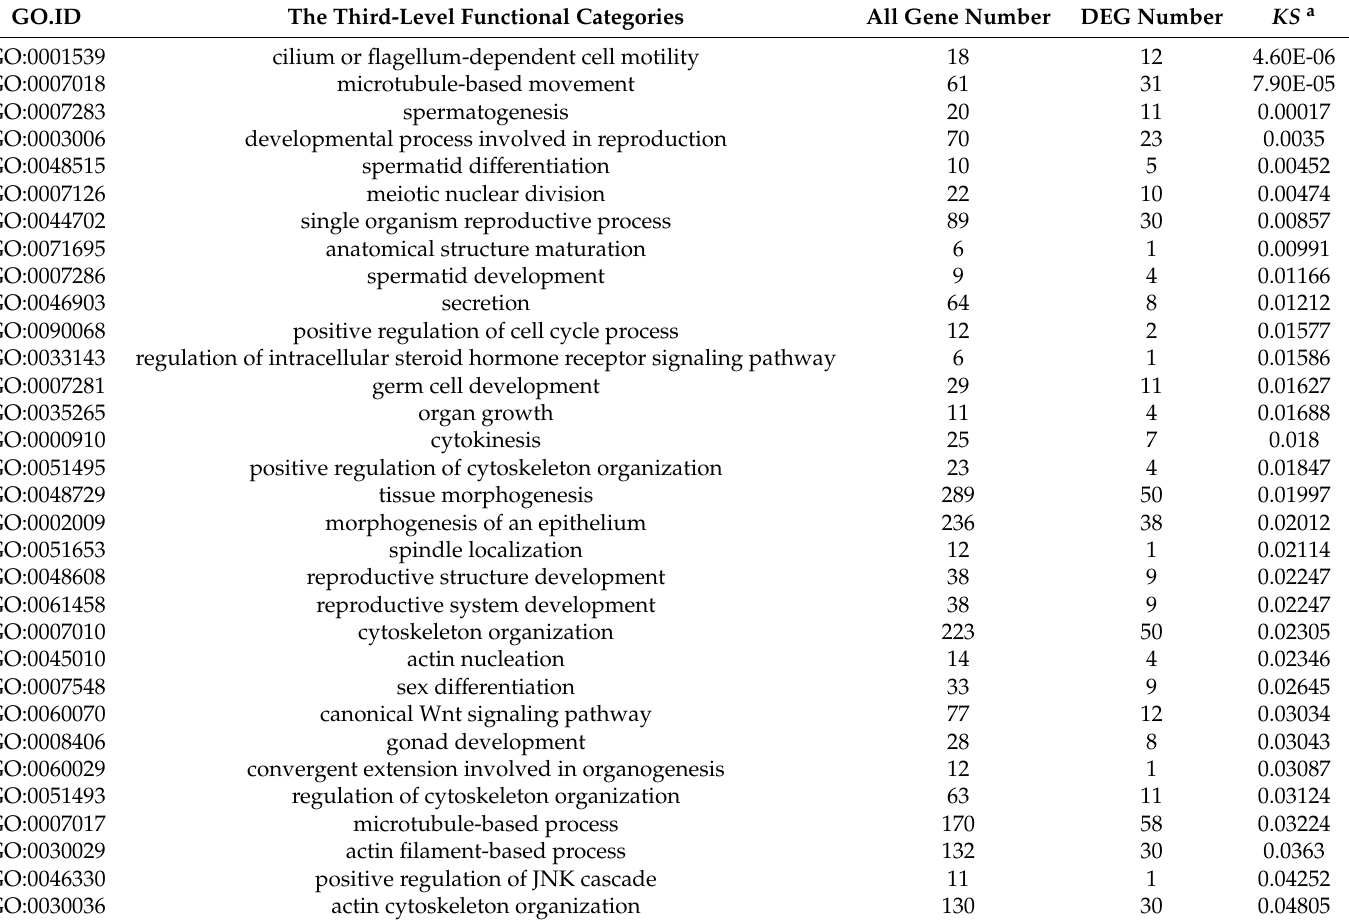
Table 4. Biological processes involved in spermatogenesis and testicular